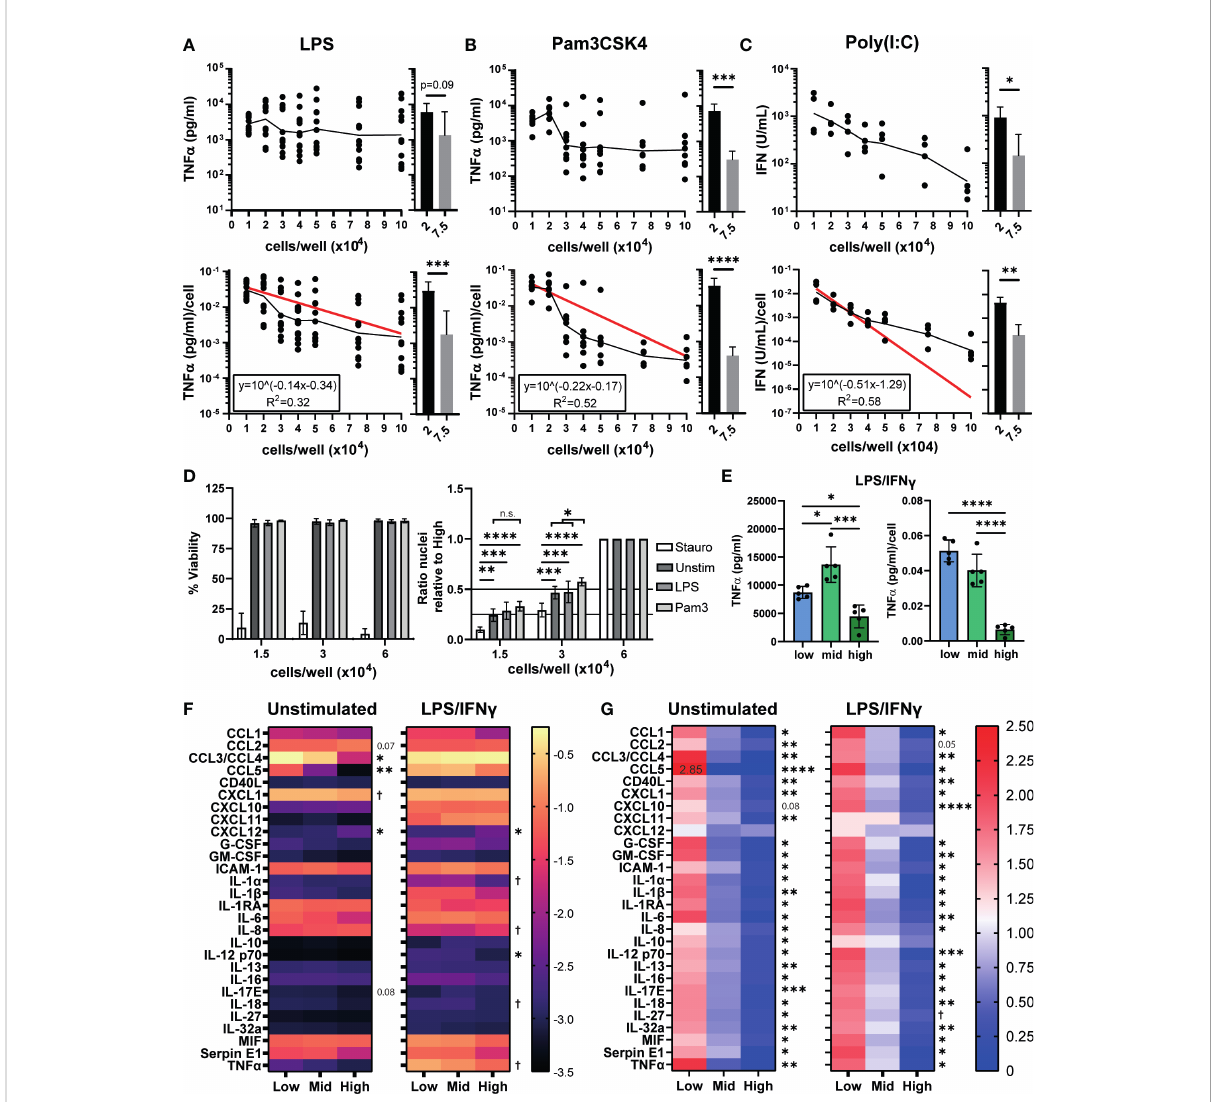
FIGURE 1 iPSC-Mac cytokine and chemokine secretion is dependent on plating density. (A, B) Secretion of TNF a determined by ELISA or (C) type I IFN determined by THP-1-reporter assay, 24 hours post stimulation from increasing densities of iPSC-Macs stimulated with (A) 1 ng/mL LPS (TLR4 agonist) (B) 1 µg/mL Pam3CSK4 (TLR2) or (C) 1 µg/mL Poly(I:C) (TLR3). Top: total concentration in 100 µL of supernatant. Bottom: concentration normalised to number of cells plated. (A-C) Scatter plot displays geometric mean (black line) and non-linear regression curve fi t (red) for normalised values. Histograms display mean +/- standard deviation (SD). Signi fi cance calculated by pairwise comparison of 2x10 4 vs 7.5x10 4 cells/well; (A) n=12 across 3 independent iPSC lines, Wilcoxon matched-pairs signed rank test, (B) n=7, 3 iPSC lines, ratio paired T-test (C) n=4, 1 iPSC line, ratio paired T-test. (D) Density effect is not due to changes in cell number after plating or stimulation. Left; percentage viable cells, right; relative total number of nuclei normalized by division against the high density condition. Cell stimulated with 3 µg/mL Staurosporine, 1 ng/mL LPS or 1 µg/mL Pam3CSK4. Mean +/- SD. n=4, 2 iPSC lines, mixed effects analysis, Tukey ’ s multiple comparisons test. (E) TNF a secretion after polarization by 100 ng/mL LPS and 20 ng/mL IFN g for 24 hours. Left; total, right; normalized to plated cell number. Mean +/- SD of n=5, 1 iPSC line, repeated measures one-way ANOVA, Tukey ’ s multiple comparison test. (F, G) Most macrophage cytokines and chemokines are in fl uenced by density. (F) Total cytokine and chemokine secretion or (G) secretion normalized against the mean of all 3 densities, in unstimulated iPSC-Macs or polarized with LPS and IFN g . (F) scale units represent the arbitrary unit pixel density normalized to a positive control (see methods), Y=Log 10 (y) transformed. (G) scale is ratio relative to the group mean. (F, G) n=3, 1 iPSC line, two-way ANOVA,